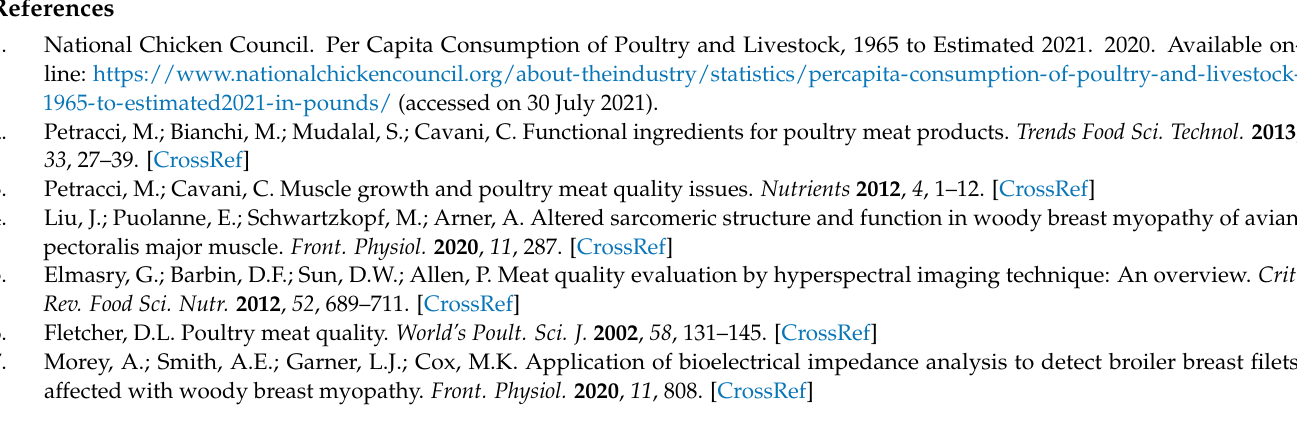
table for number of fillets classified in each labeled categories in testing data set using split data set method; Figure S1: Diagrammatic representation of k -means clustering; Figure S2: Diagrammatic representation of steps in k - nearest neighbor clustering analysis; Figure S3: Different clusters formed for hand-held BIA data collected for different severity level of fillets; Figure S4: Different clusters formed for plate BIA data collected for different severity level of fillets; Figure S5: Graph for optimal number of clusters based on Silhouette Index value for handheld BIA dataset; Figure S6: Graph for optimal number of clusters based on Silhouette Index value for plate BIA dataset; Figure S7: Density graph representing average distribution and overlapping of resistance (A) based on different severity levels; Figure S8: Density graph representing average distribution and overlapping of reactance (B) based on different severity levels; Figure S9: Density graph representing average distribution and overlapping of fillets weights (Wt) based on different severity levels; Figure S10: Hand-held BIA collected data graph for repeated cross validation accuracy for SVM model with cost function; Figure S11: Repeated cross validation accuracy graph for plate BIA collected data in SVM model with cost